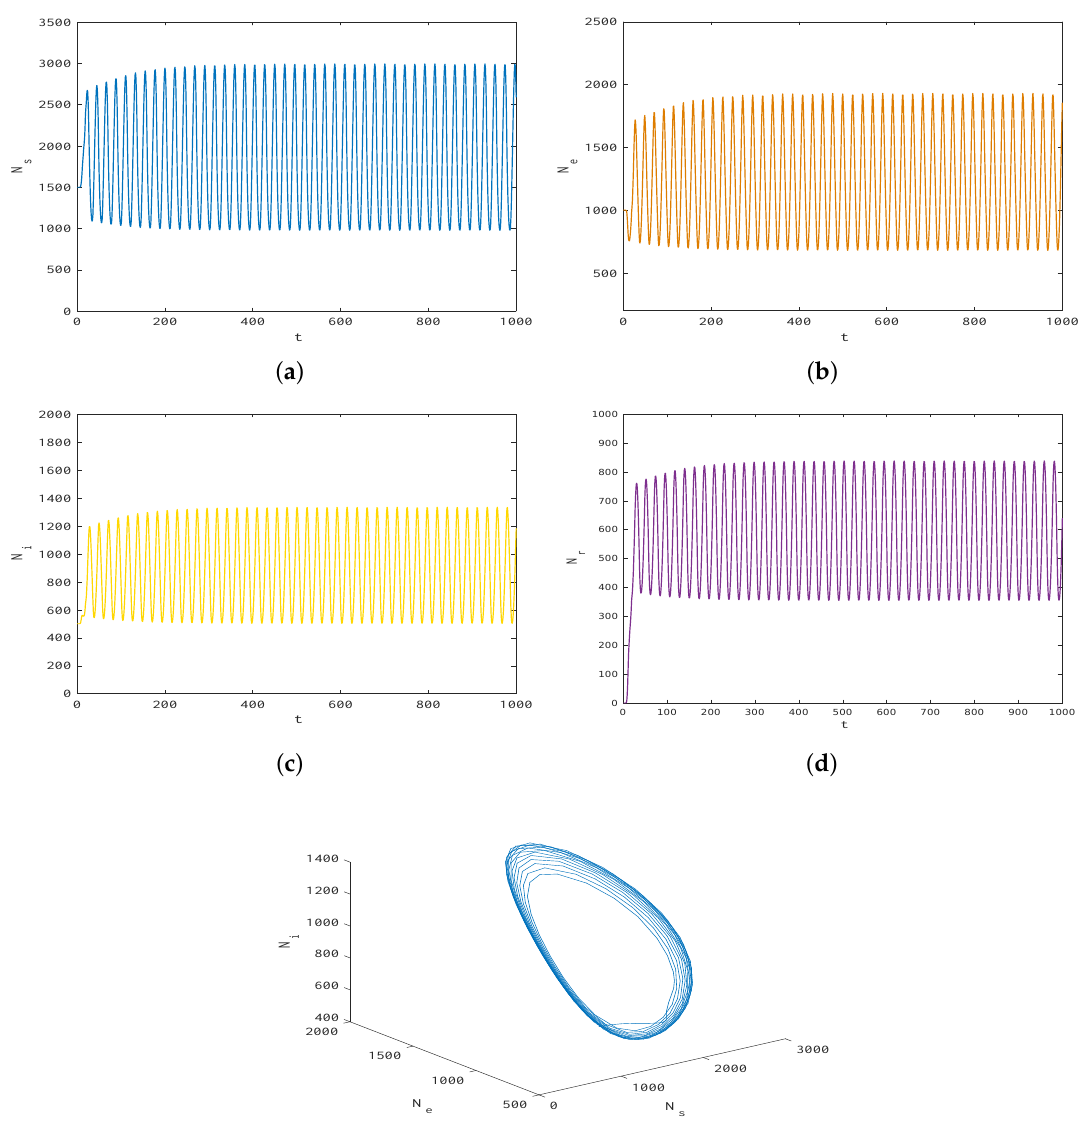
Figure 4. Instability of the endemic equilibrium point H ∗ = ( N ∗ s , N ∗ e , N ∗ ( a ) Time response diagram of N s ; ( b ) Time response diagram of N e ; ( c ) Time response diagram of N i ; ( d ) Time response diagram of N r ; ( e ) Phase diagram of N s , N e and N i